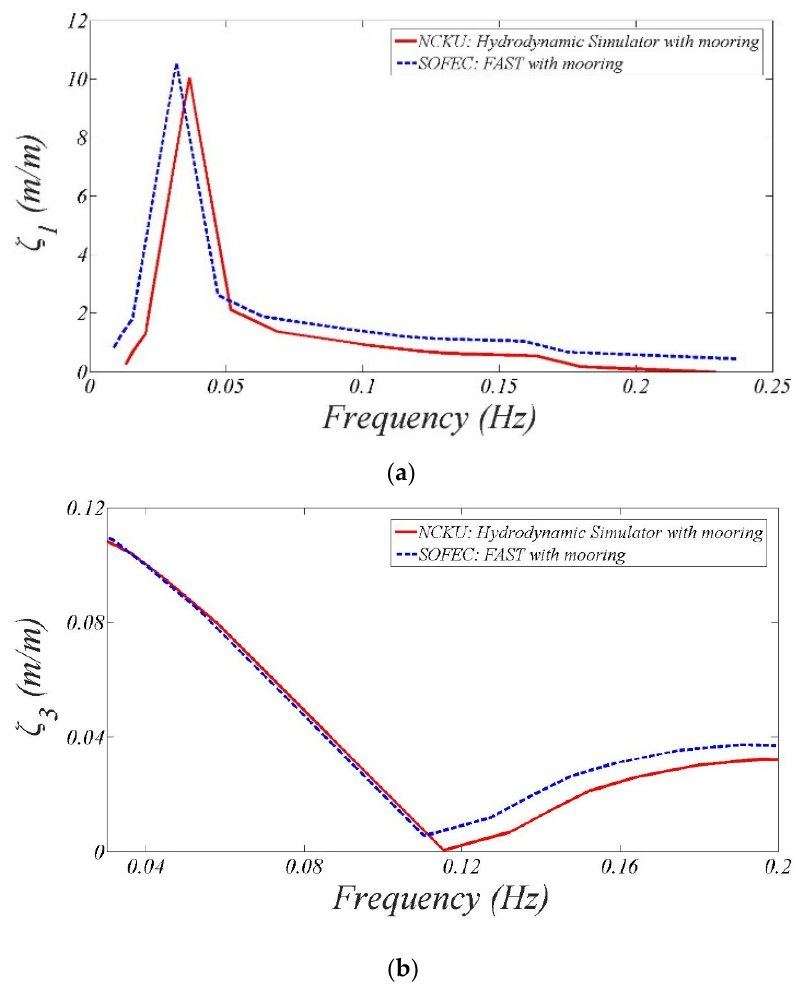
Figure 19. The performance of ( a ) surge and ( b ) heave RAOs as a function of wave frequency for the MIT/NREL TLP by comparing hydrodynamic simulator with FAST.